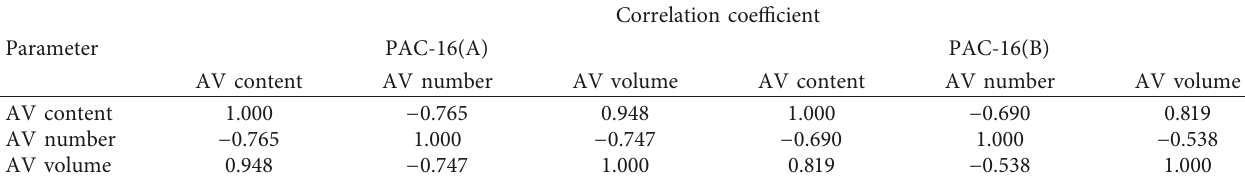
Figure 6: Vertical AV distribution in PA specimens at various AV contents of 16% and 20%, respectively: (a) AV content, (b) AV number, and (c) AV volume. Table 4: Correlations among the three distributional